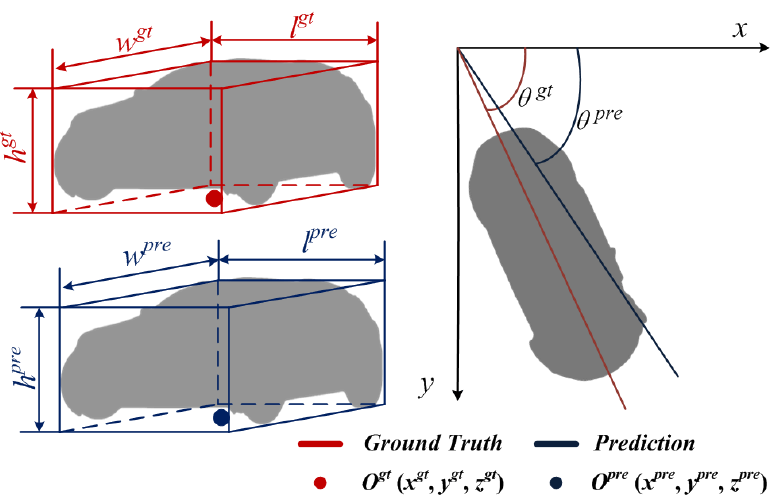
Figure 10. The parameterization of the bounding